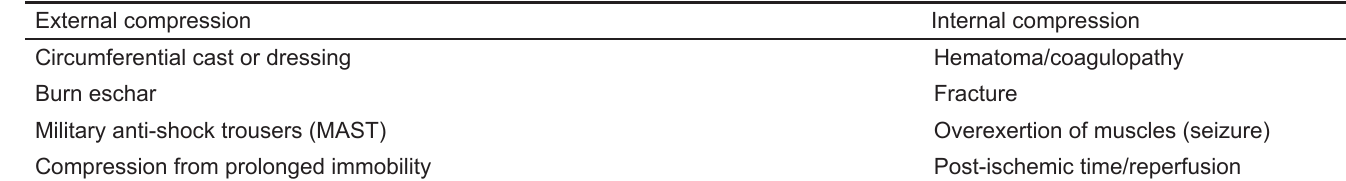
Table. Etiology of acute compartment